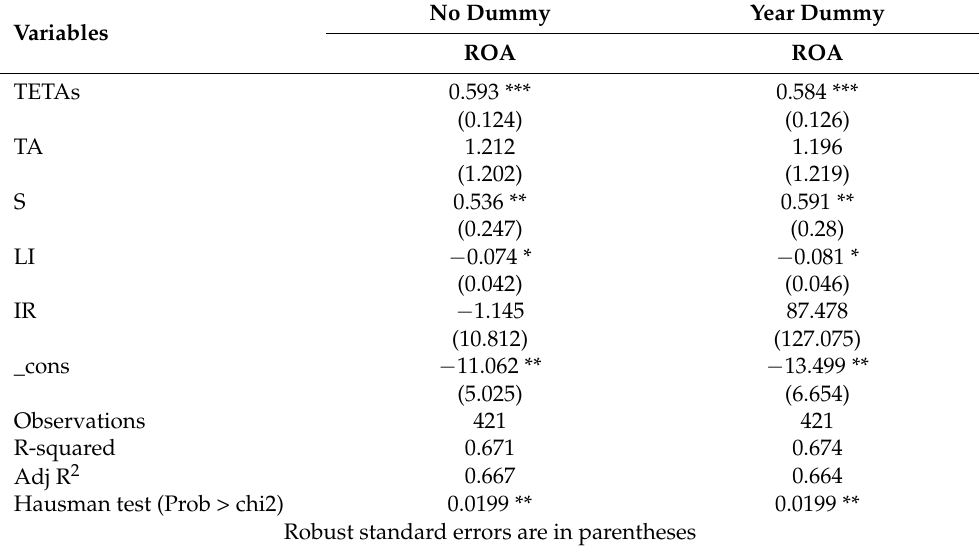
Table 12. Results of the Fixed Effects of TETAs on ROA, as per Panel Data